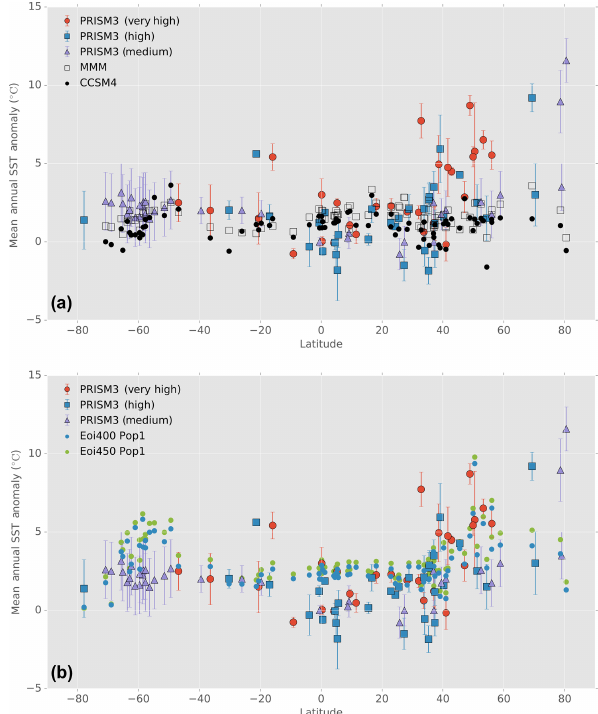
Figure 13. Data–model comparison of the mid-Pliocene SST anomaly compared to preindustrial. The data in both (a) and (b) are the PRISM3 estimates (Dowsett et al., 2010), which have been categorized into three confidence categories (Dowsett et al., 2012). (a) Comparison of the PRISM3 estimates to the multi-model mean from PlioMIP1 (transparent black square markers) and to the anomalies obtained by Rosenbloom et al. (2013) for PlioMIP1 (black dots) using the same CCSM4 model that we use in this study. (b) Comparison of the PRISM3 estimates to the anomalies obtained from our two mid-Pliocene simulations, E oi 400 P (cid:104) 2691 , 2720 (cid:105) and E oi 450 P (cid:104) 2621 , 2650 (cid:105) , shown as blue and green dots, respectively. The (cid:104)(cid:105) denotes the range of model years over which the climatology was